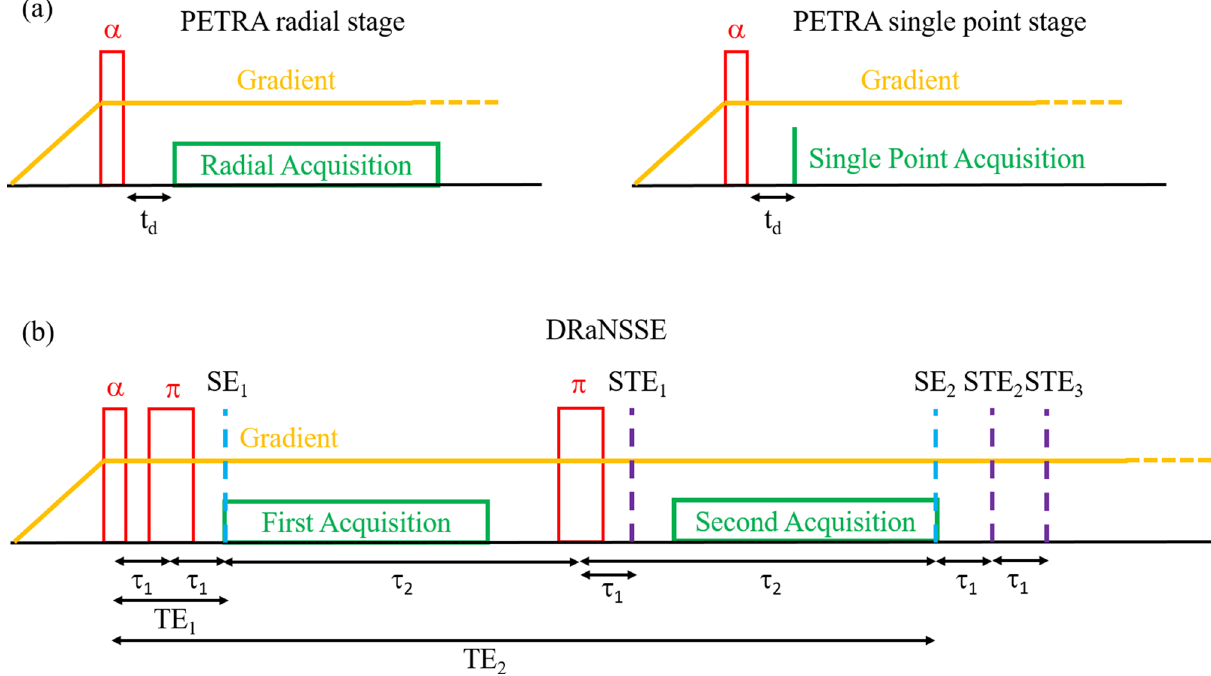
Figure 7. Sequence diagram for a single repetition of ( a ) PETRA and ( b )